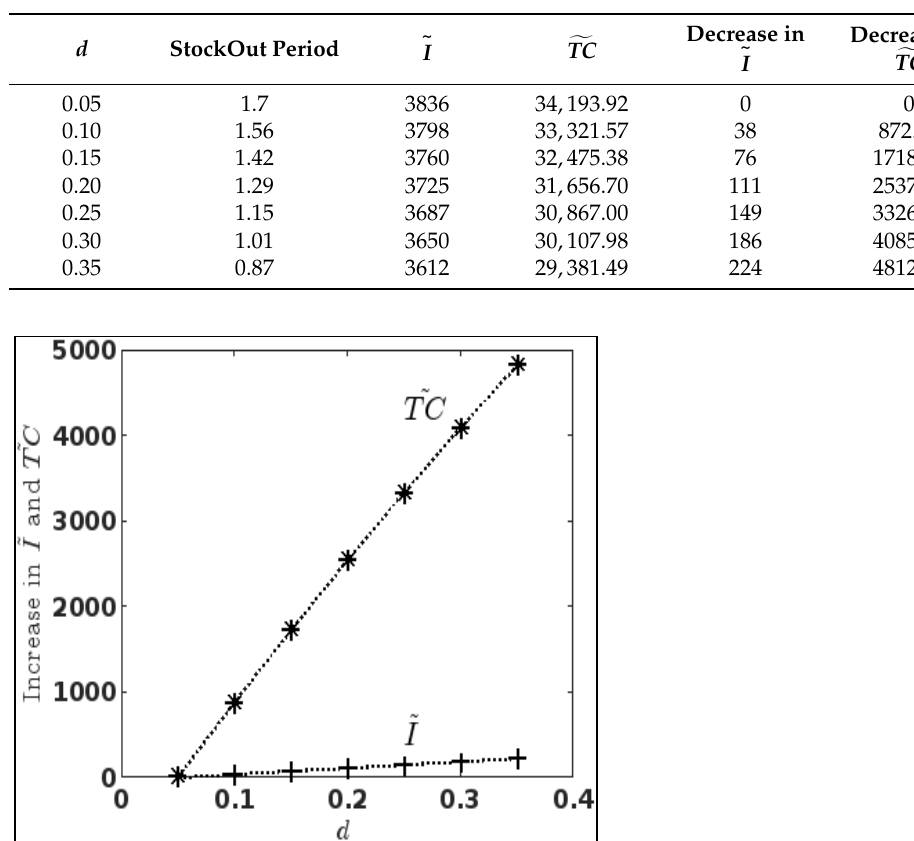
Figure 4. Effect of backlogging rate on optimizing the total cost and ordering quantity. Table 4. Effect of penalty upon late payment of purchasing cost on optimizing the total cost. Table 3. Effect of discount rate on purchasing cost when optimizing the total cost.